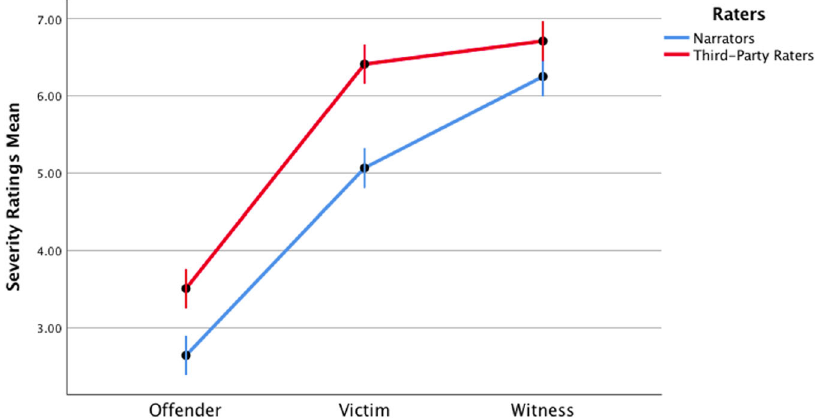
Fig. 2 Mean sexual violence severity ratings of narrators and recipients. The fi gure shows the mean severity ratings for offenders, victims and witnesses divided into narrators and recipients (i.e., third-party raters).